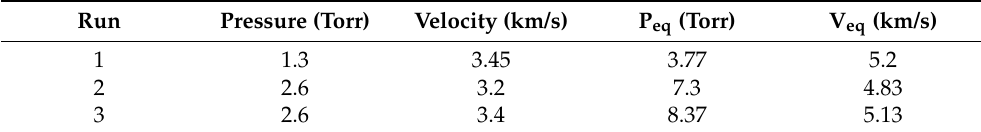
Table 4. Test conditions run in KAIST shock-tube